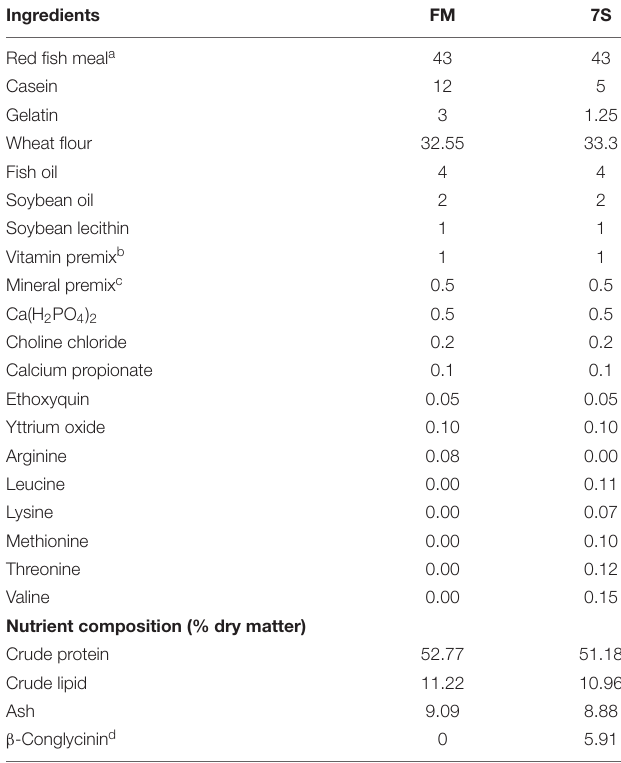
FIGURE 1 | The SDS-PAGE profile of purified β -conglycinin fraction. Lane 1: protein marker; Lane 2: β -conglycinin fraction. α (cid:48) , α , and β are subunits of β -conglycinin, and Ax and Bx are acidic and basic subunits of glycinin (see Supplementary Figure S2 for the original blots).